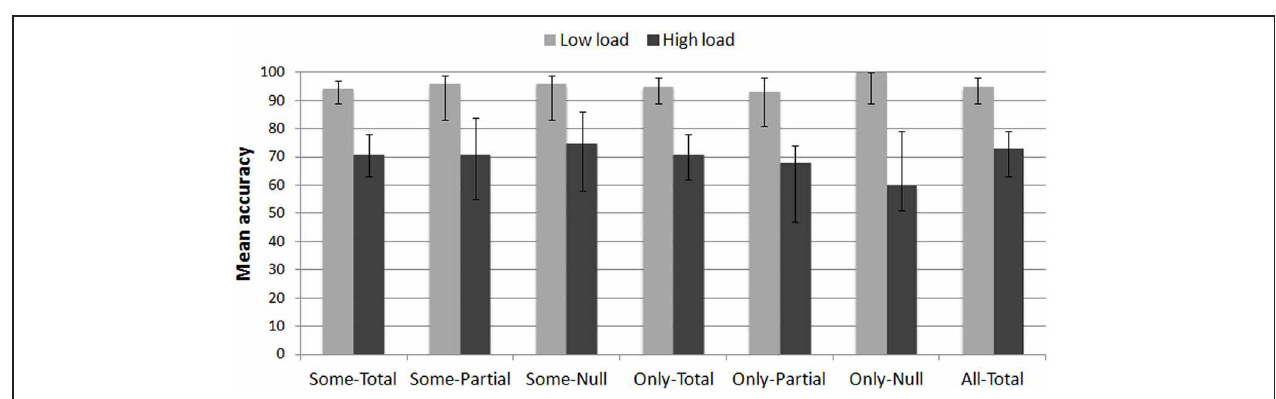
the HIGH LOAD trials ( M = 95%, CI 95% [93, 97]) than in